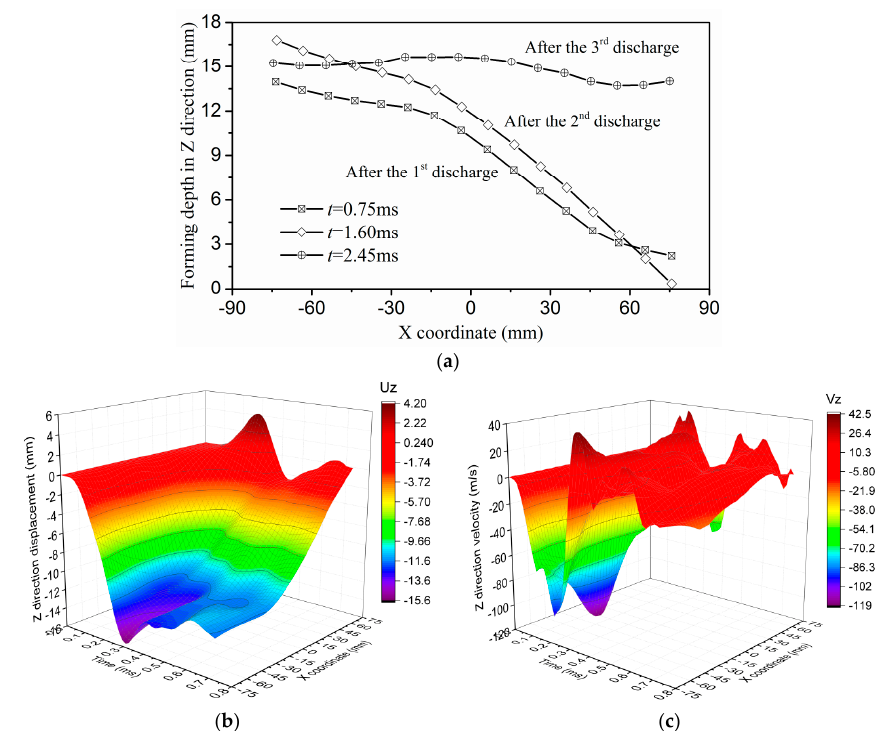
Figure 6. Z -direction results. ( a ) Z -direction displacement after three discharges along the X path; ( b ) Z -direction velocity and ( c ) of GP along the X path in position A.